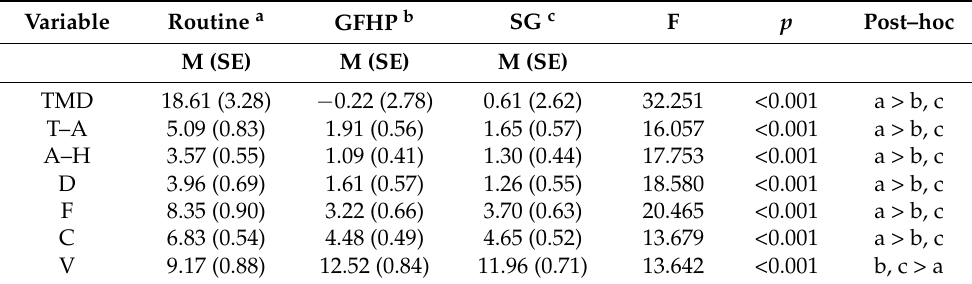
Table 2. The results of the one-way repeated measures of ANOVA of Profile of Mood State (POMS)